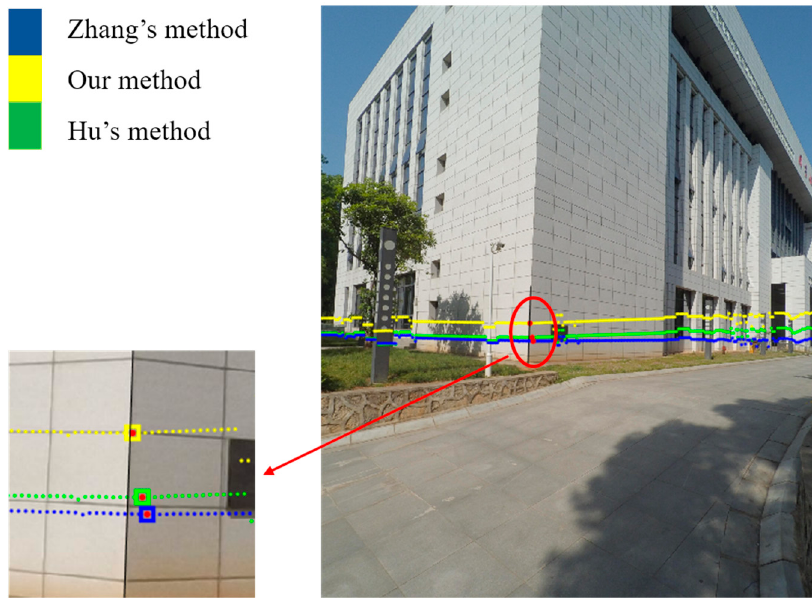
Figure 17. Projection of LRF range data on the image (outdoor).